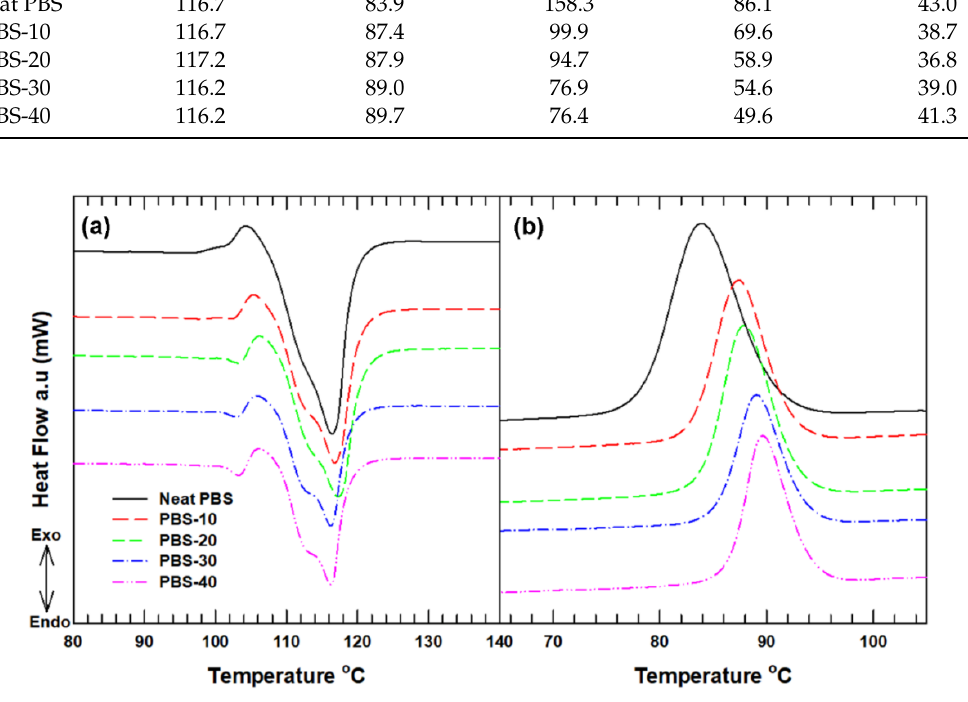
Figure 3. DSC thermogram of the neat PBS and the PBS composites: ( a ) heating (endothermic) peaks and ( b ) cooling (exothermic) peaks. Table 1. Thermal behavior of the neat PBS and its composites. T m —melting temperature; T c —